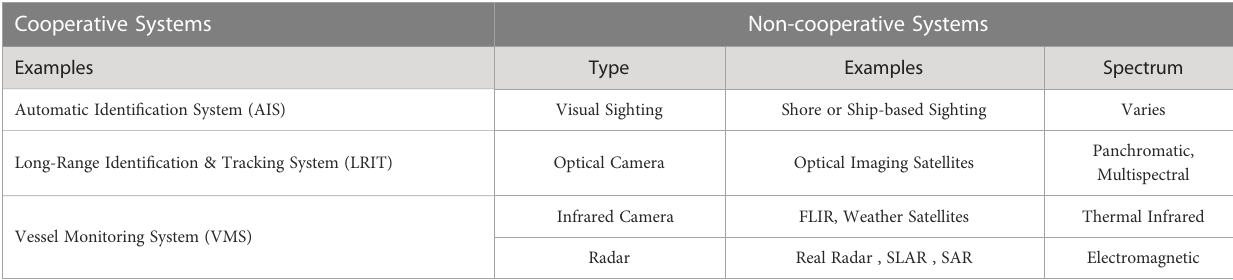
TABLE 1 Cooperative vs Non Cooperative